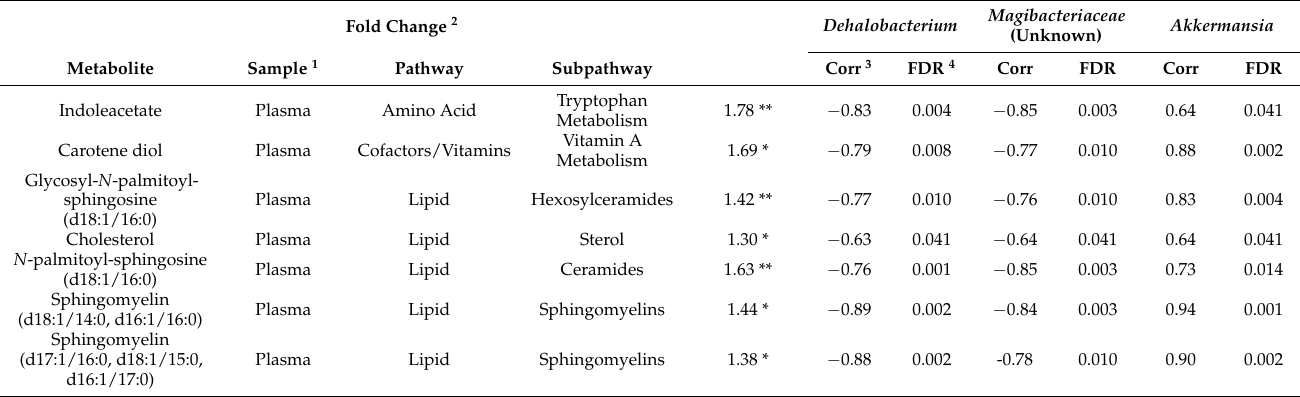
Table 2. Correlation analysis between fructose-responsive plasma metabolites and fecal microbiota in B6 mice. Fold Change 2 Dehalobacterium